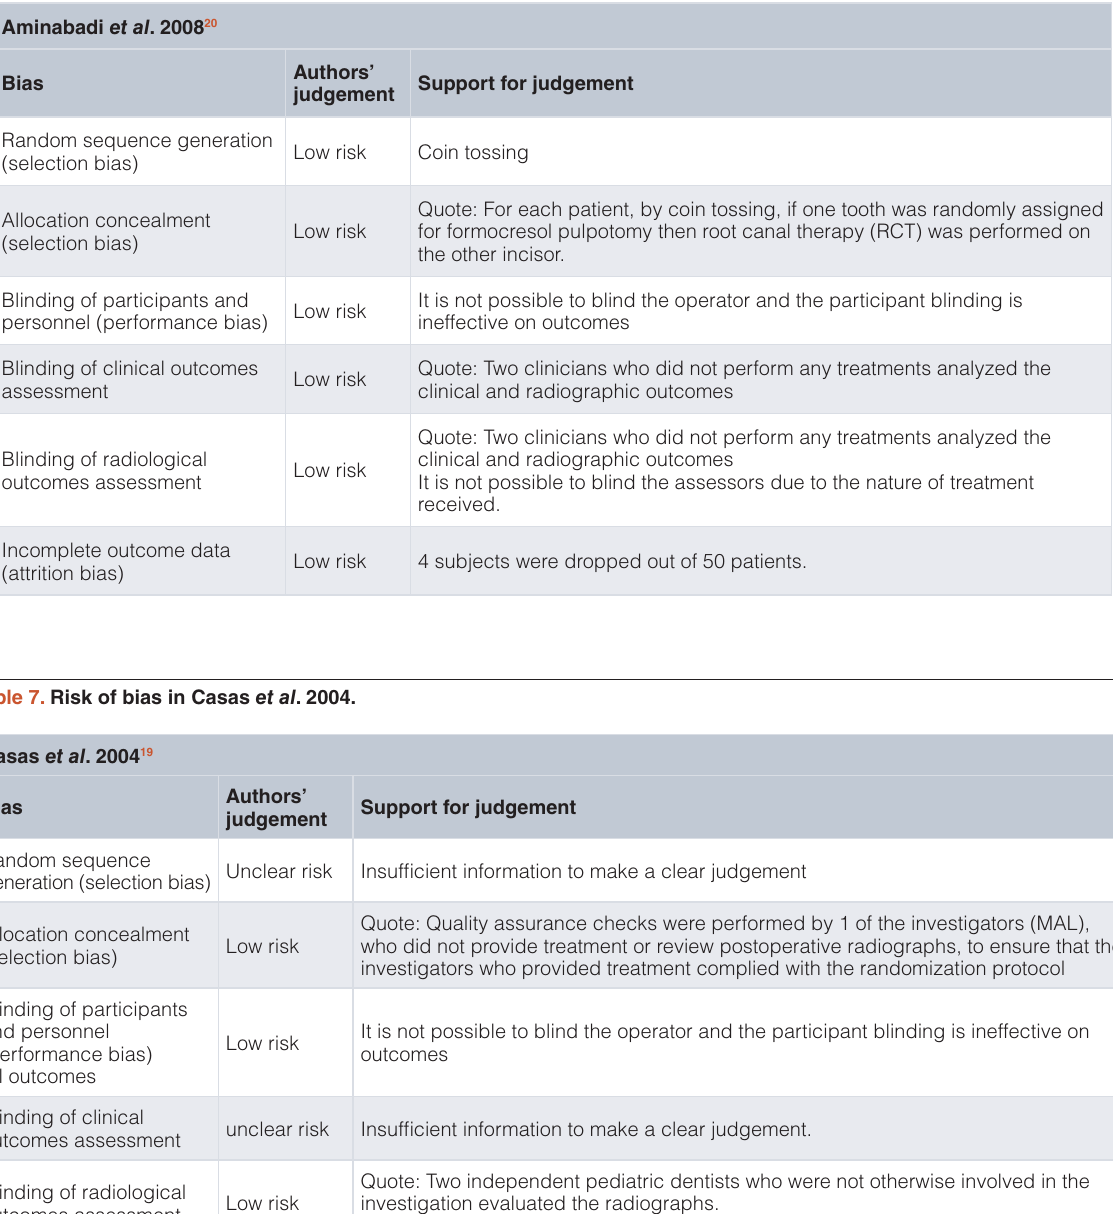
Table 6. Risk of bias in Aminabadi et al .